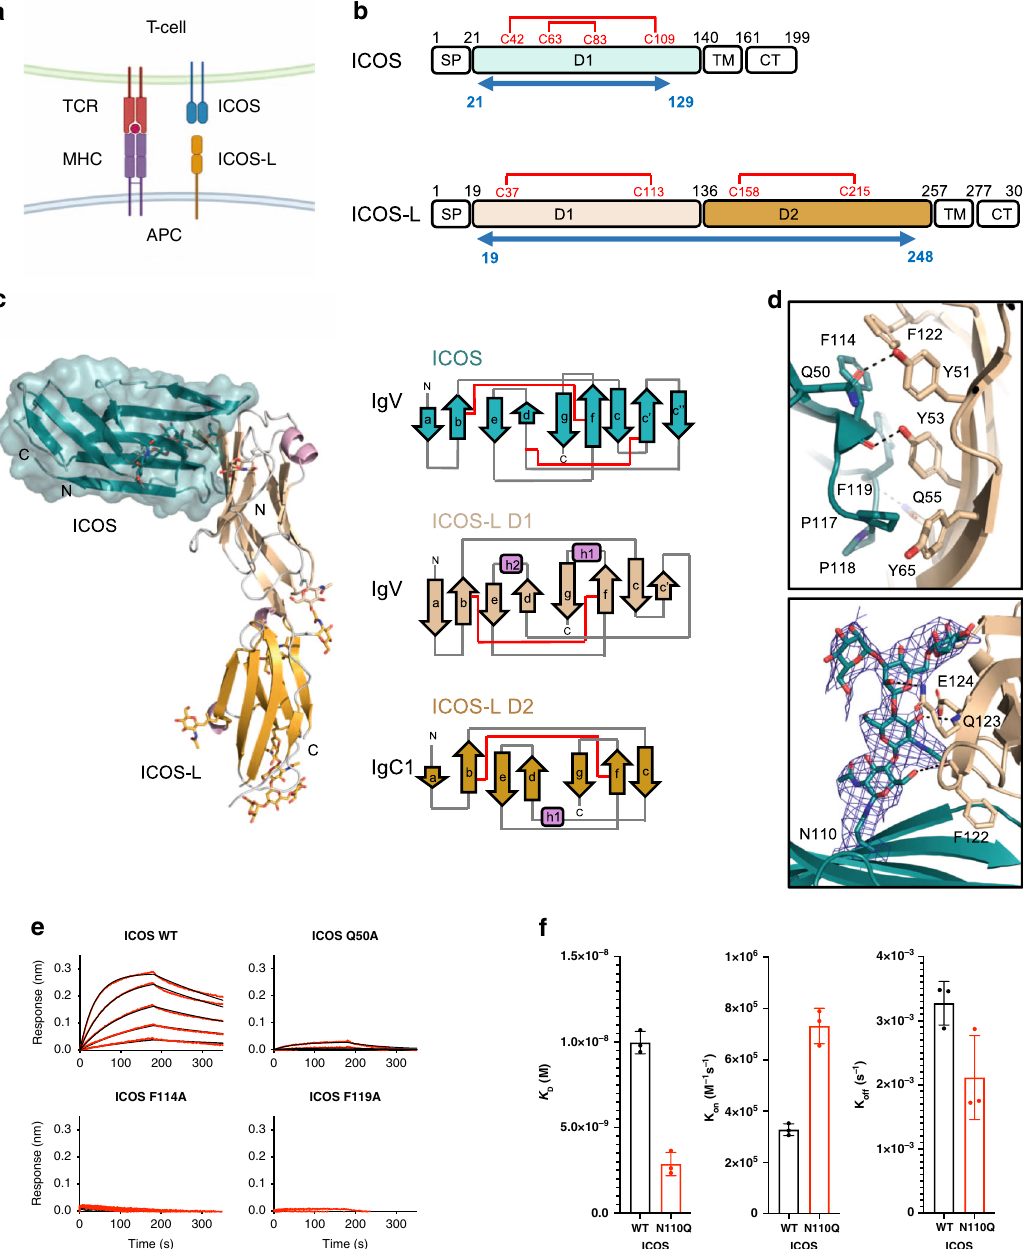
Fig. 1 Three-dimensional structure of the human ICOS/ICOS-L complex. a Schematic representation of the ICOS/ICOS-L co-stimulatory interaction. Antigen-presenting cell (APC), T-cell receptor (TCR), Major Histocompatibility Complex (MHC), Inducible Co-stimulator (ICOS), Inducible Co-stimulator ligand (ICOS-L). b Domain organization of ICOS and ICOS-L; signal peptide (SP), extracellular domains (D1-D2), transmembrane (TM) domain, and cytoplasmic tail (CT). Disul fi de bonding pattern is shown with red lines. Blue arrows indicate the length of the crystalized ectodomains. c Secondary structure cartoon representation of the side view of the ICOS/ICOS-L complex. ICOS (deep teal, transparent surface) adopts a V-type Ig fold while ICOS-L adopts a V-type Ig fold (wheat) followed by a C1-type Ig domain fold (orange). The helices are shown in light pink. d Detailed view of the receptor-ligand interface. Top: the 114 FDPPF 119 motif in the FG loop of ICOS forms key hydrophobic interactions with aromatic residues from ICOS-L shown in stick representation. Hydrogen bonds between ICOS and ICOS-L are shown as black dashed lines. Bottom: The blue mesh around the N110 glycan depicted as sticks represent a composite omit electron density map contoured at 1.0 sigma. Colors are as in ( c ). e Kinetic binding curves of ICOS-L to ICOS WT and ICOS mutants. Mutation of residues Q50, F114, and F119 abolished binding in BLI. f Comparison of the binding af fi nity ( K D ), association (on), and dissociation ( k off ) rates of ICOS-L to WT ICOS and to ICOS N110 glycan knock-out mutant (N110Q). The mean values and standard deviation of three biological replicates are